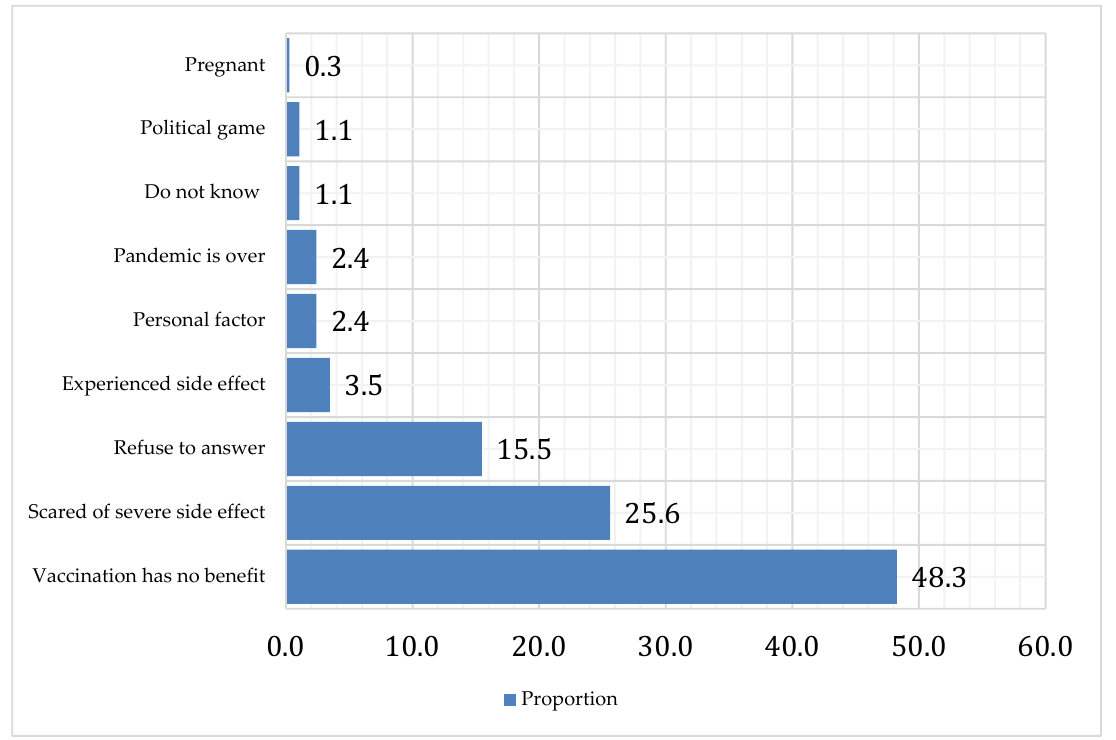
Figure 3. The leading causes behind COVID-19 booster dose vaccine rejection among the partici- pants.